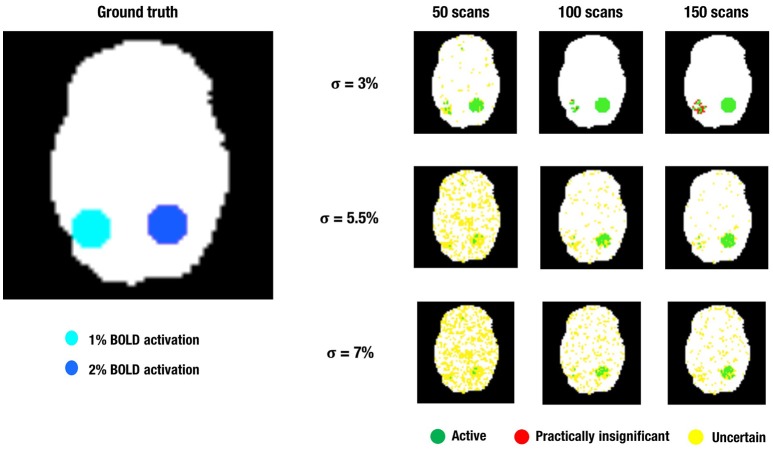
This figure shows a visual representation of the ground truth (Left) and the different layers of the LPSM after ABT (Right) for one iteration in the simulations. α = 0.001 and β = 0.2 in all scenarios shown.